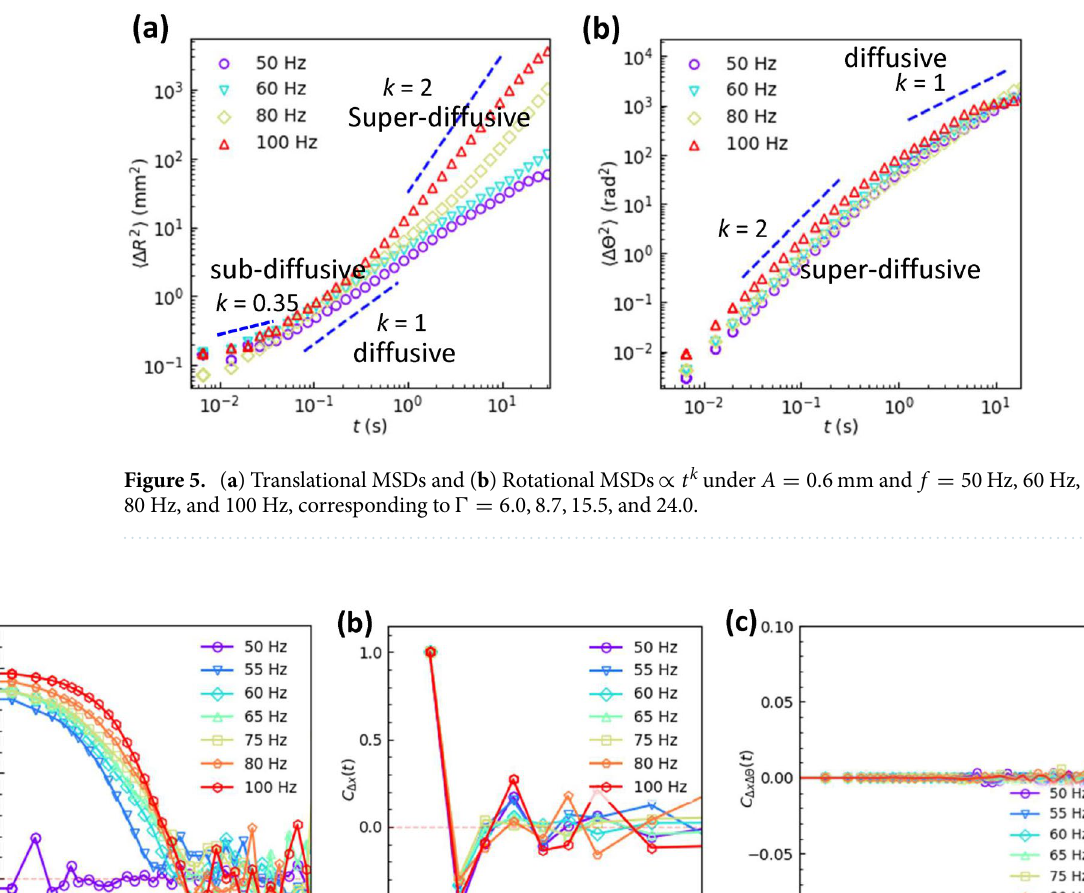
Figure 6. Time autocorrelation functions C ( t ) of the ( a ) translational displacements (cid:31) x and ( b ) angular displacements �θ under various f . ( c ) The cross-correlations of the translational motion and rotational motion. 50 Hz, 60 Hz, 80 Hz, and 100 Hz, corresponding to Ŵ 0.6 mm. f A = =